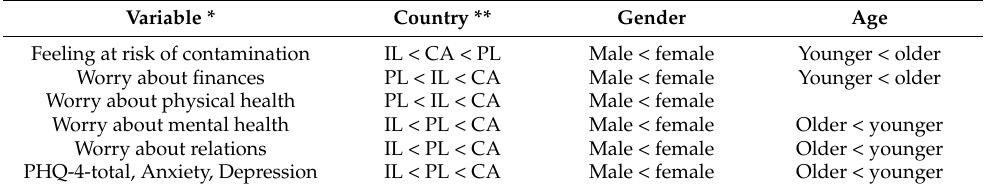
Table 2. Summary of the study main